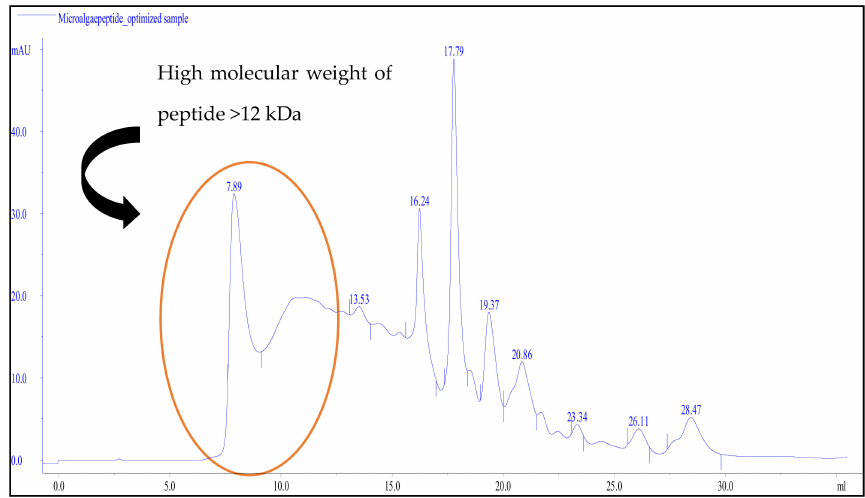
Figure 11. Fast Pressure Liquid Chromatography (FPLC) chromatogram of microalgae protein hydrolysate before fractionation using ultrafiltration membrane at a wavelenghth of 734